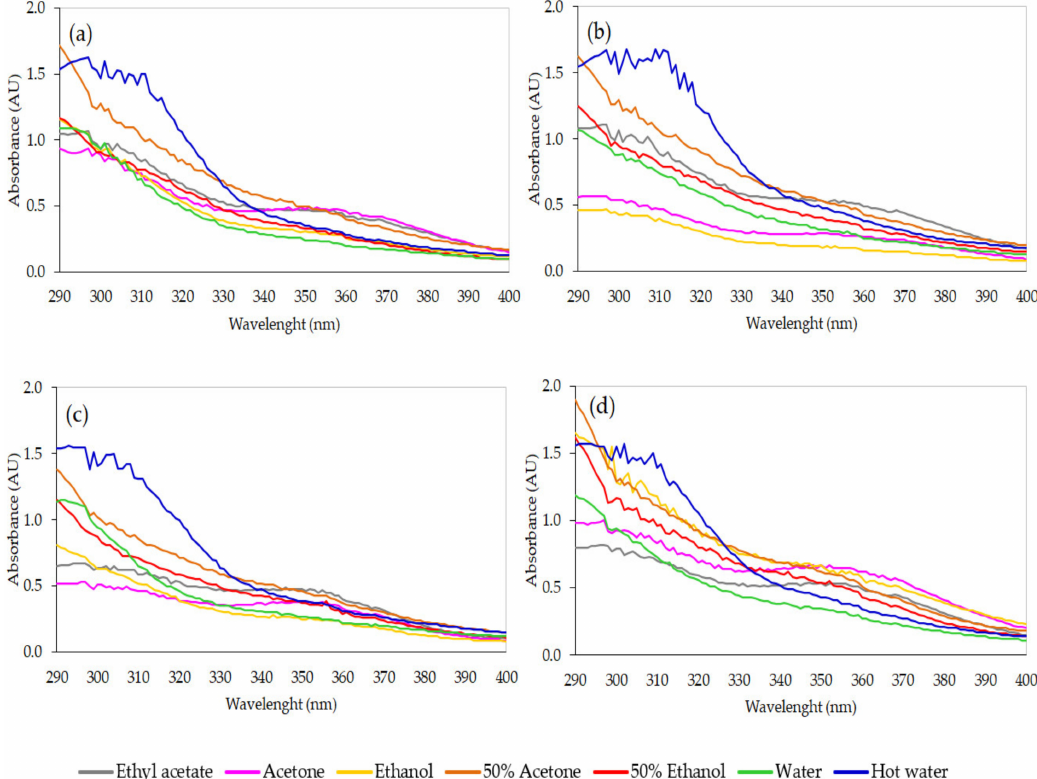
Figure 5. UVB and UVA absorption patterns of crude extracts prepared from solid-based residues (SBRs) using different solvents: ( a ) SBR-B; ( b ) SBR-R; ( c ) SBR-Rb; and ( d )